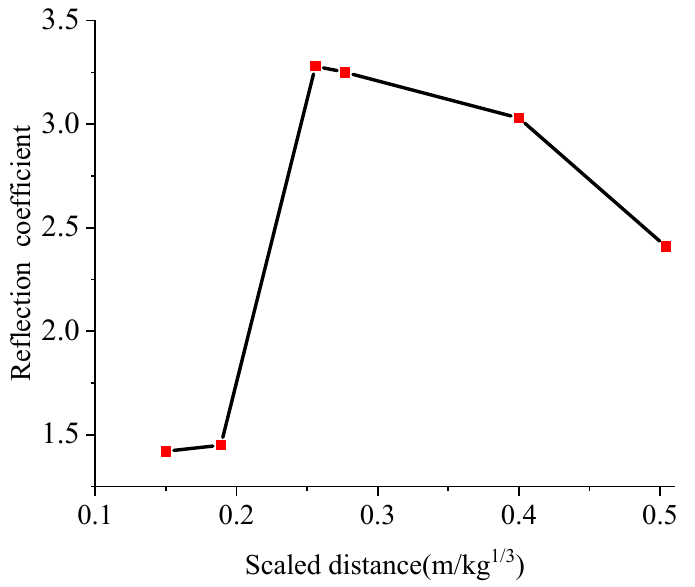
Figure 11. Relationship between the scaled distance and the reflection coefficient.